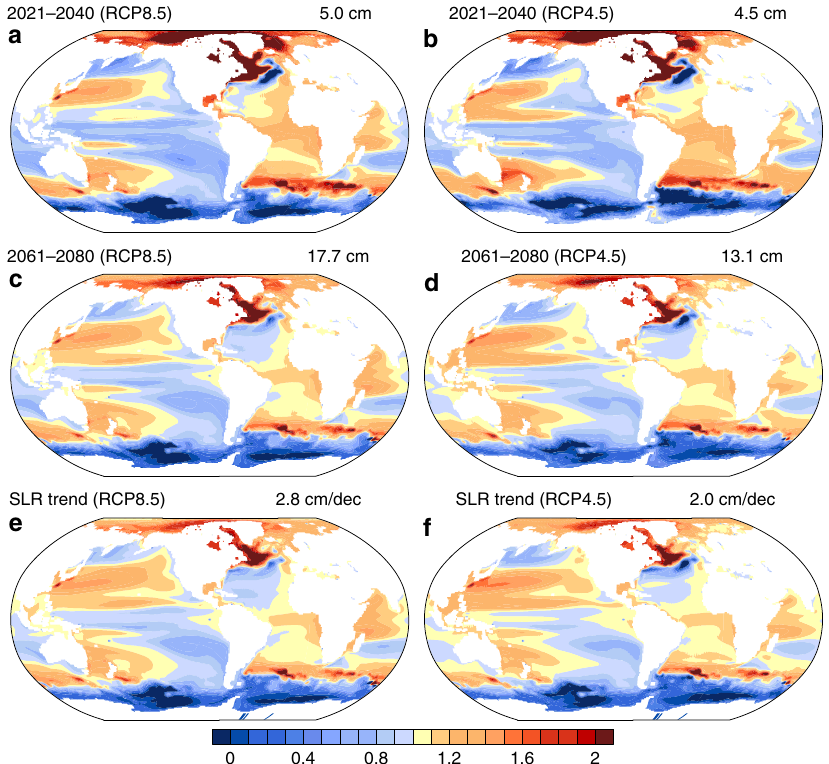
Fig. 1 Ratio of ensemble averaged 20-year mean sea level rise and the decadal trend of sea level rise and the global mean. a – d The mean sea level rise and e , f the decadal sea level rise trend. The numbers on the top right of each panel are the ensemble global mean value, and shading in all panels have been divided by those global mean values which leads to a unitless shading pattern. For a – d , the ensemble global mean sea level rise is relative to the ensemble mean sea level of 1986 – 2005. The decadal trend is the average 10-year trend over the period 2006 – 2080. The left panels are for RCP8.5 and right panels for